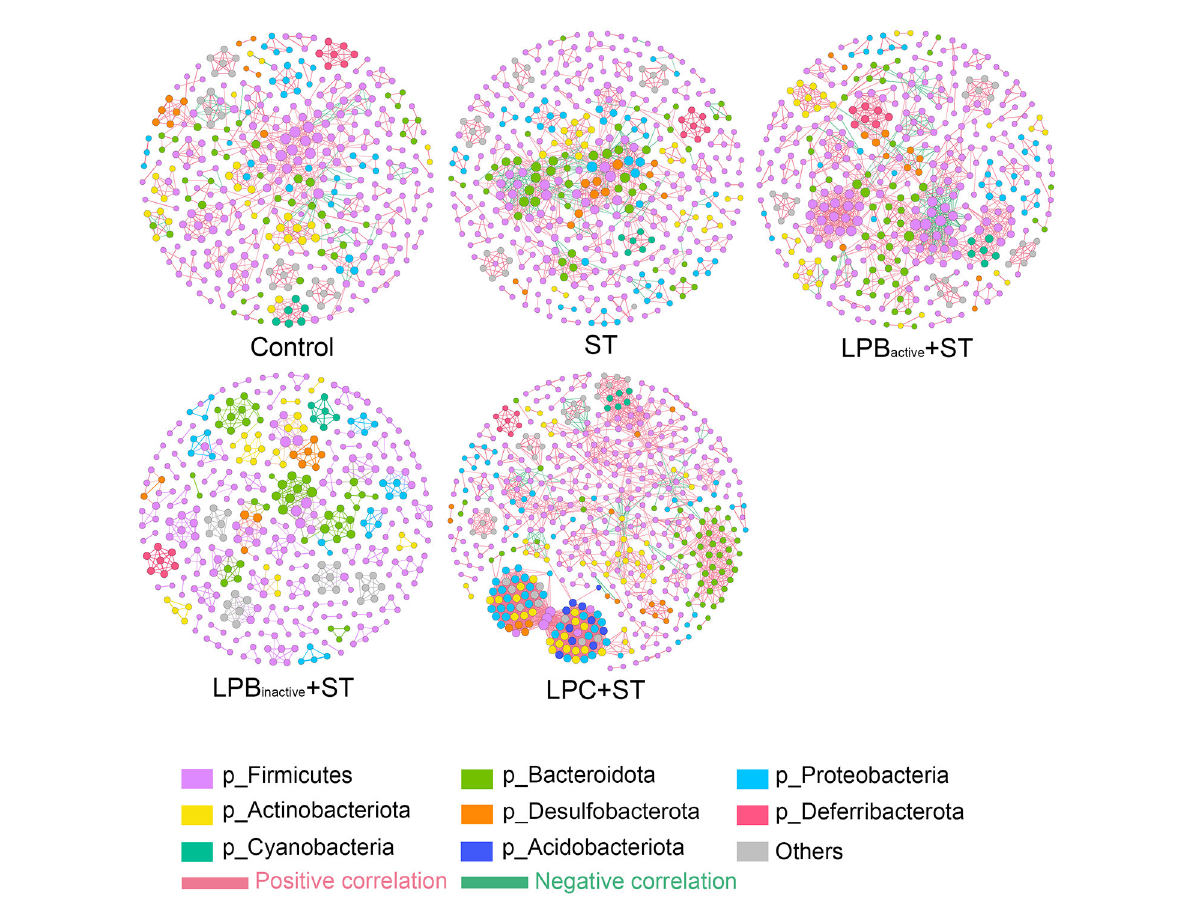
FIGURE12 Co-occurrence networks of microbial communities. A connection represents a very strong (Spearman’s R > 0.6) and significant (FDR-adjusted p < 0.05) correlation. The size of each node is proportional to the relative abundance; the thickness of each connection (edges) between two nodes is proportional to the value of Spearman’s correlation coefficients. Red and green lines, respectively indicate the positive and negative